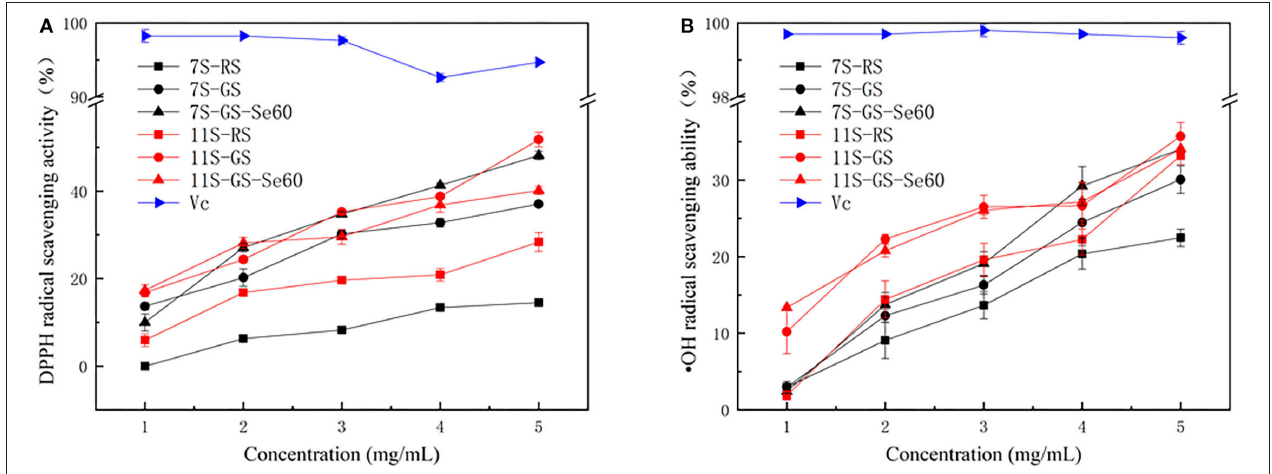
FIGURE 5 | 1,1-Diphenyl-2-picrylhydrazyl (DPPH) radical scavenging activity (A) and hydroxyl free ( · OH) radical scavenging ability (B)